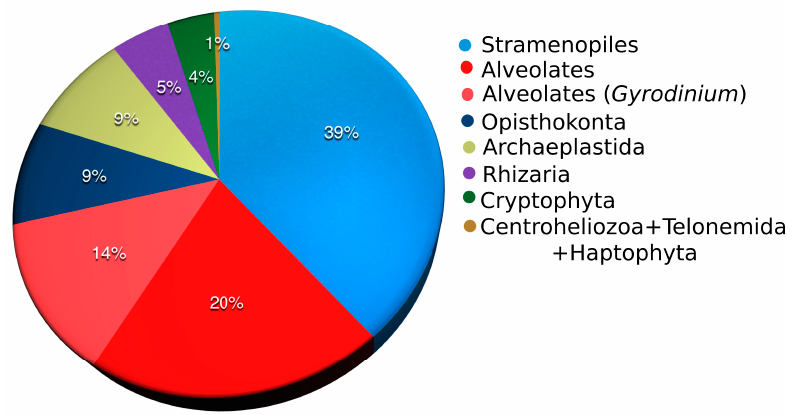
Figure 2. Relative abundance of protist high-rank groups in Lake Baikal.